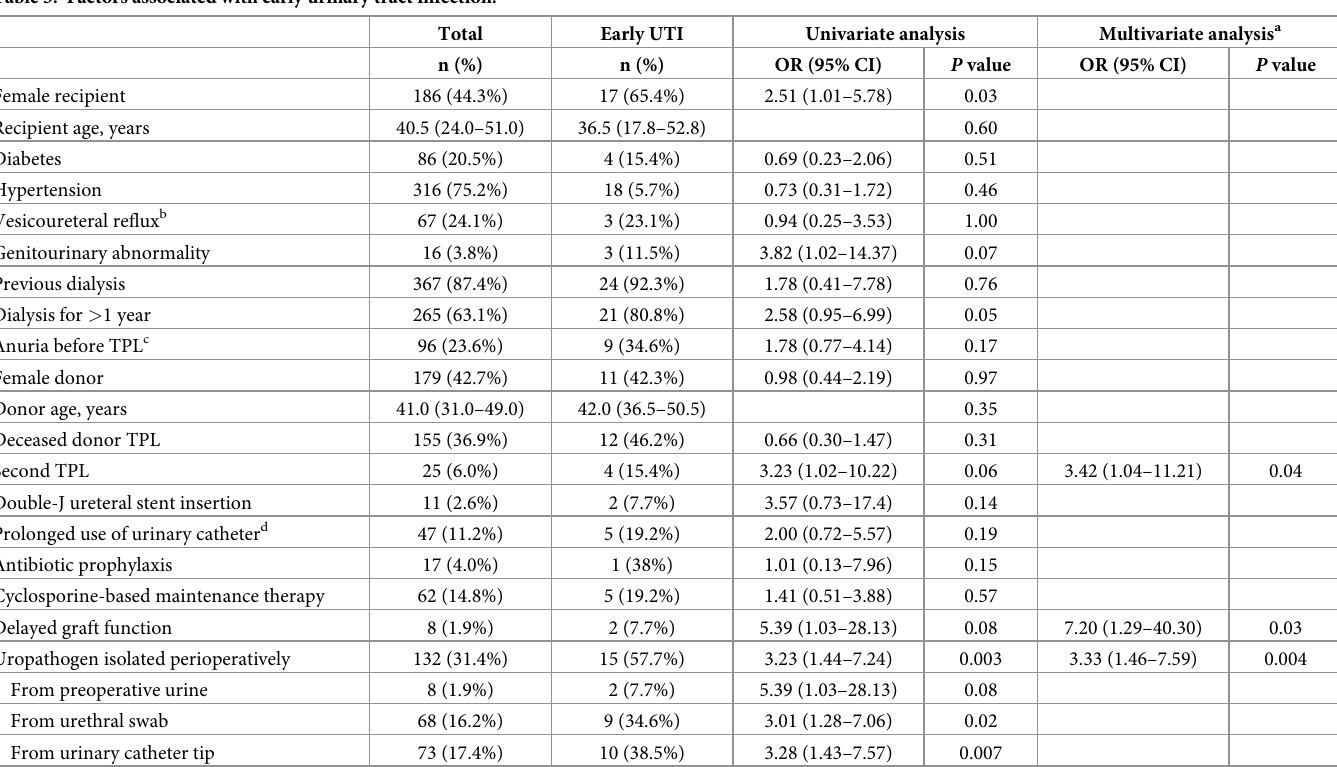
Table 3. Factors associated with early urinary tract